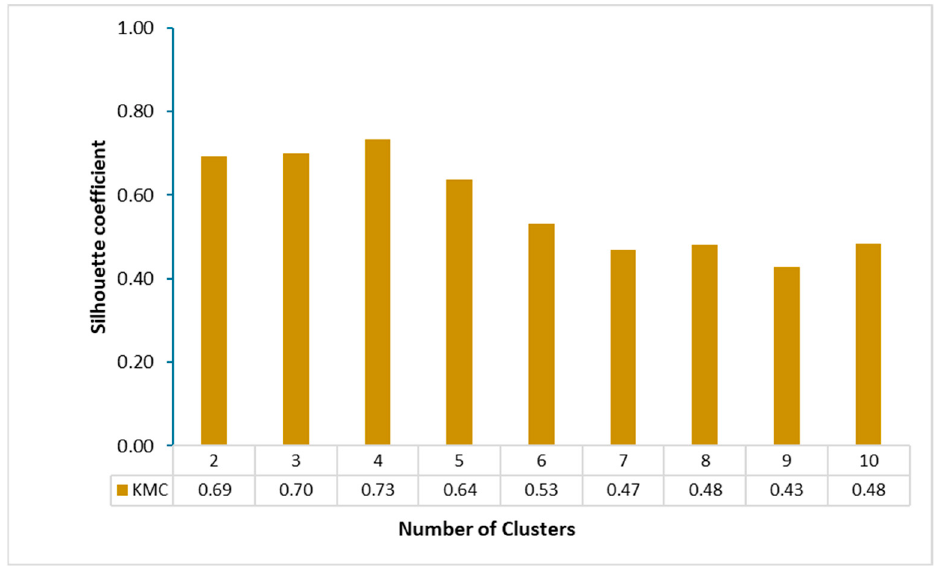
Figure 4. Plot showing number of clusters and silhouette scores of K-mean